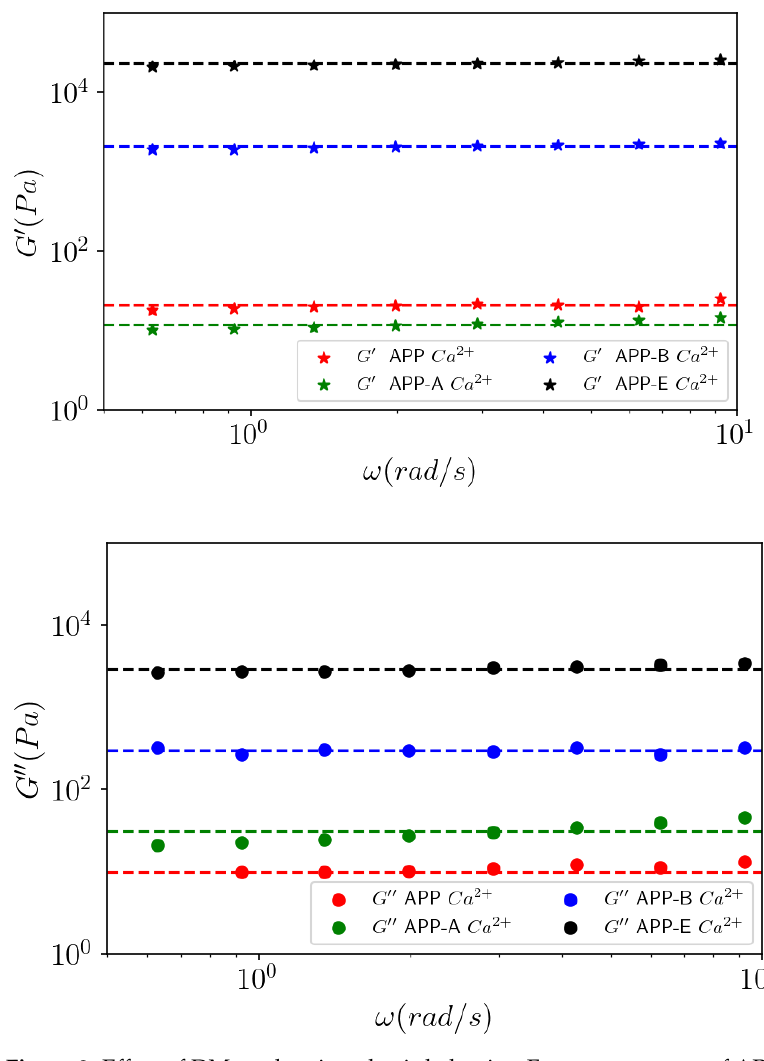
Figure 9. Effect of DM on the viscoelastic behavior. Frequency sweep of APP, APP-A, APP-B, and APP-E at 10 g L − 1 in 1 mol L − 1 CaCl 2 at 25 ◦ C for an applied oscillatory strain γ = 0.1%. Stars correspond to the elastic modulus G′ (Pa) and full dots correspond to the viscous modulus G ″ (Pa). Table 4. The role of DM on the effective polymer concentration and on the degree of gel swelling formed by dialysis of 10 g L − 1 solutions against 1 mol L − 1 CaCl 2